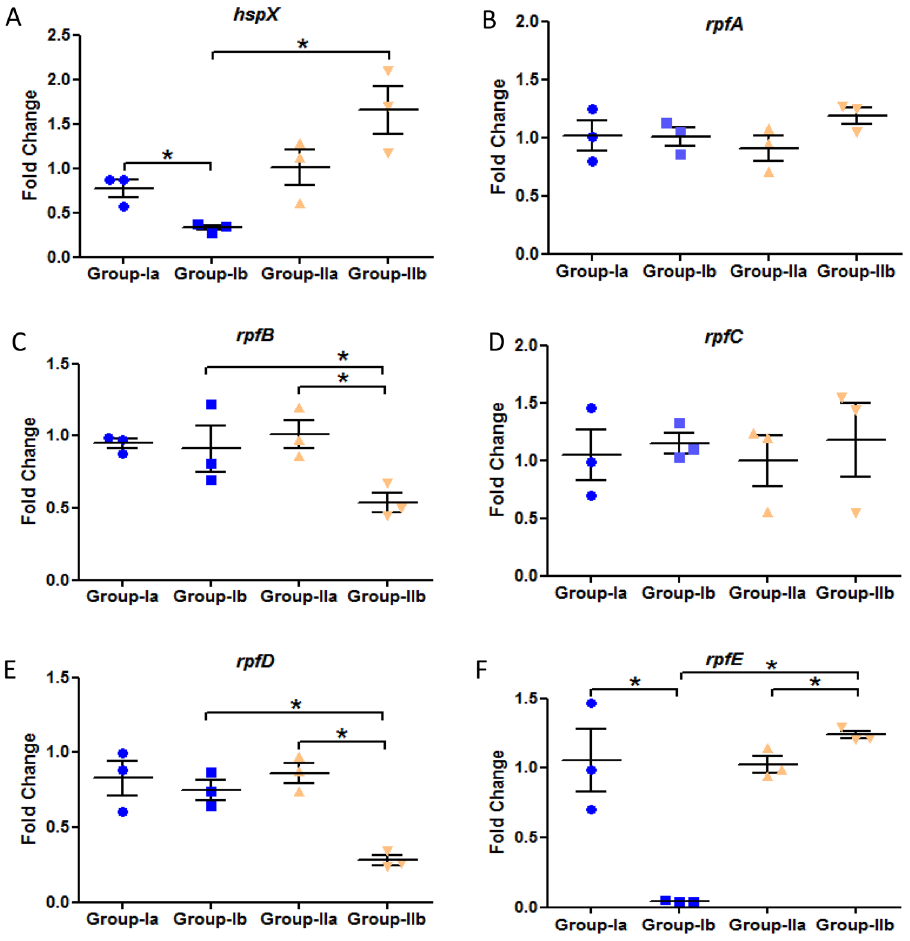
Figure 7. Gene expression analysis of various genes in untreated and treated groups. Gene expression of ( A ) hspX ( B ) rpfA ( C ) rpfB ( D ) rpfC ( E ) rpfD ( F ) rpfE in lungs of untreated and INH + RIF treated latent tuberculosis and latent tuberculosis with diabetes group. The data were represented as Mean ± SE of 3 animals in each group and no statistically significant changes were observed in the expression of hspX and rpf genes. Group-Ia: latent tuberculosis untreated, Group-Ib: latent tuberculosis treated with INH + RIF, Group-IIa: latent tuberculosis with diabetes untreated, Group-IIb: latent tuberculosis with diabetes treated with INH + RIF. Animal model was developed only once but gene expression was studied in triplicates from each